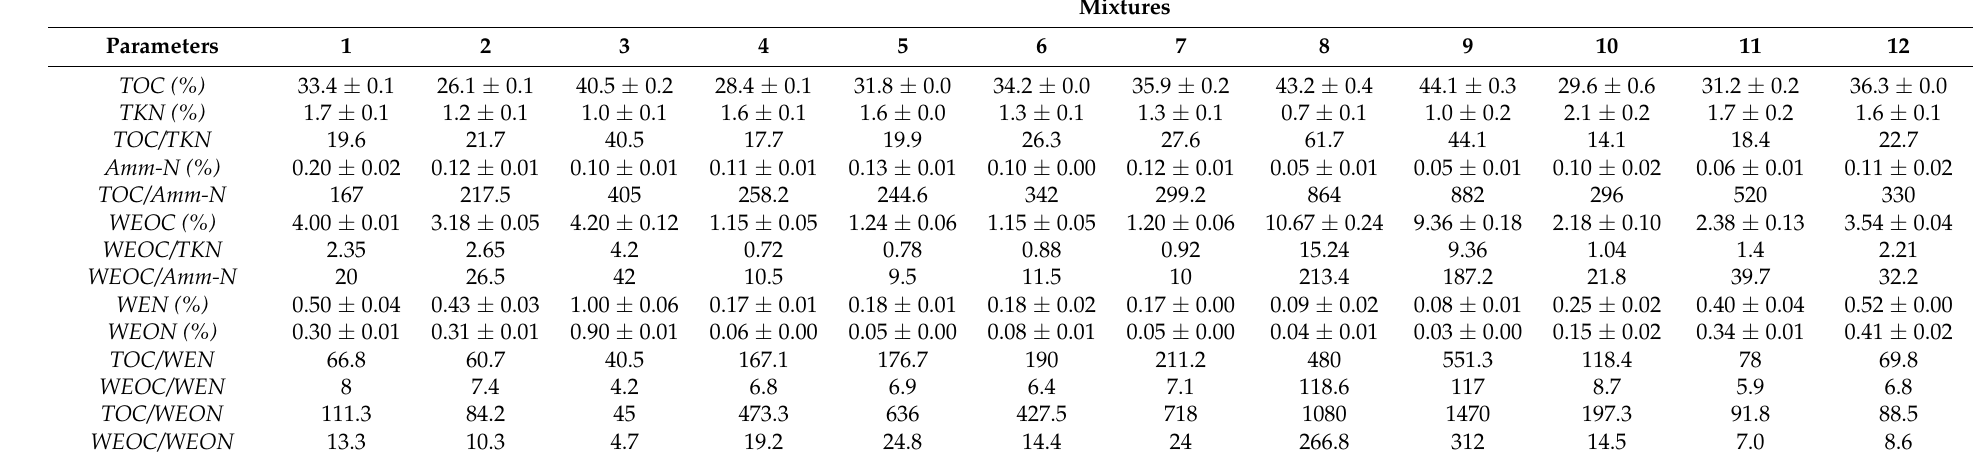
Table 5. Total organic C, total Kjeldahl N, ammonium-N, water-extractable C, N and organic N and their ratios in the